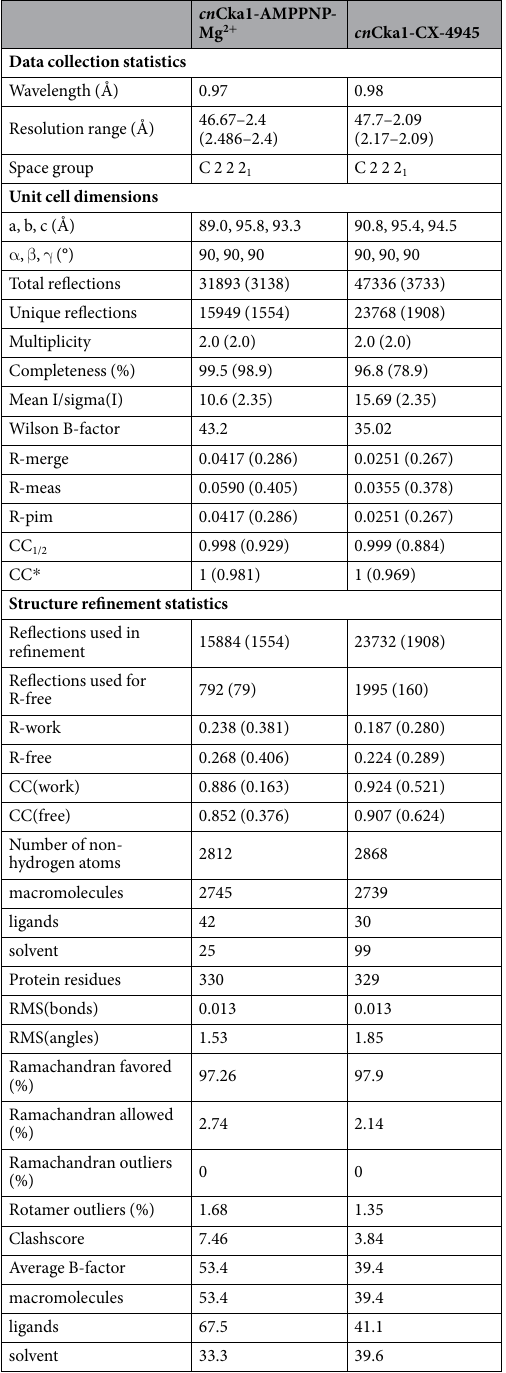
Table 1. Data-collection and refinement statistics. * Values in parentheses are for the highest-resolution